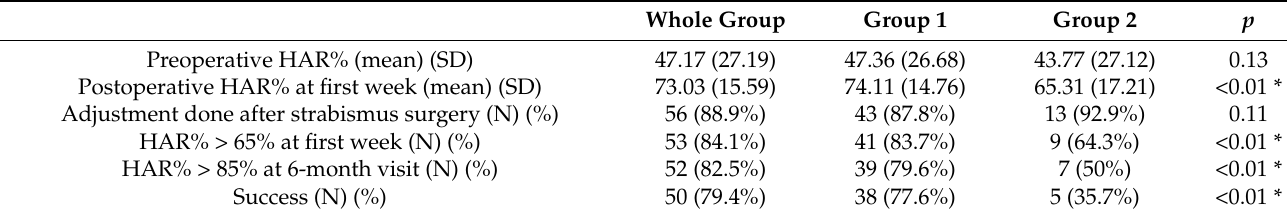
Table 3. Detailed patient information after strabismus